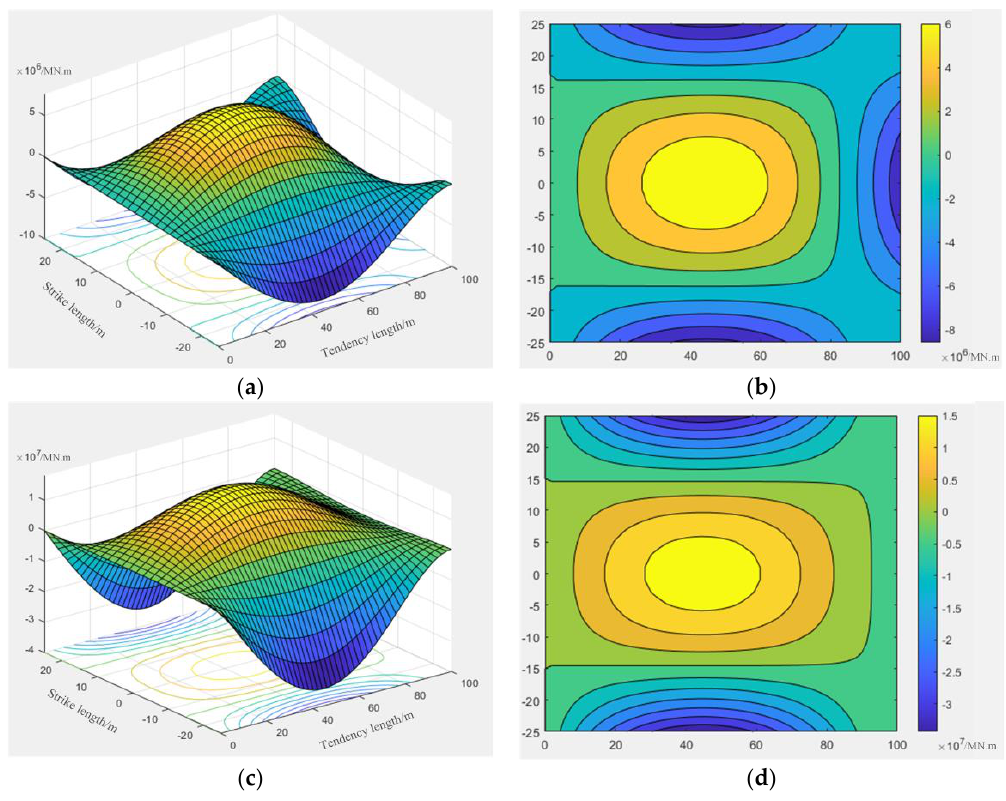
Figure 9. Three-dimensional surface contour map of internal force distribution of three-sided fixed supported and one-sided simply supported plate. ( a ) Diagram of bending moment M x ; ( b ) M x stress isoline diagram; ( c ) Diagram of bending moment M y ; ( d ) My stress isoline